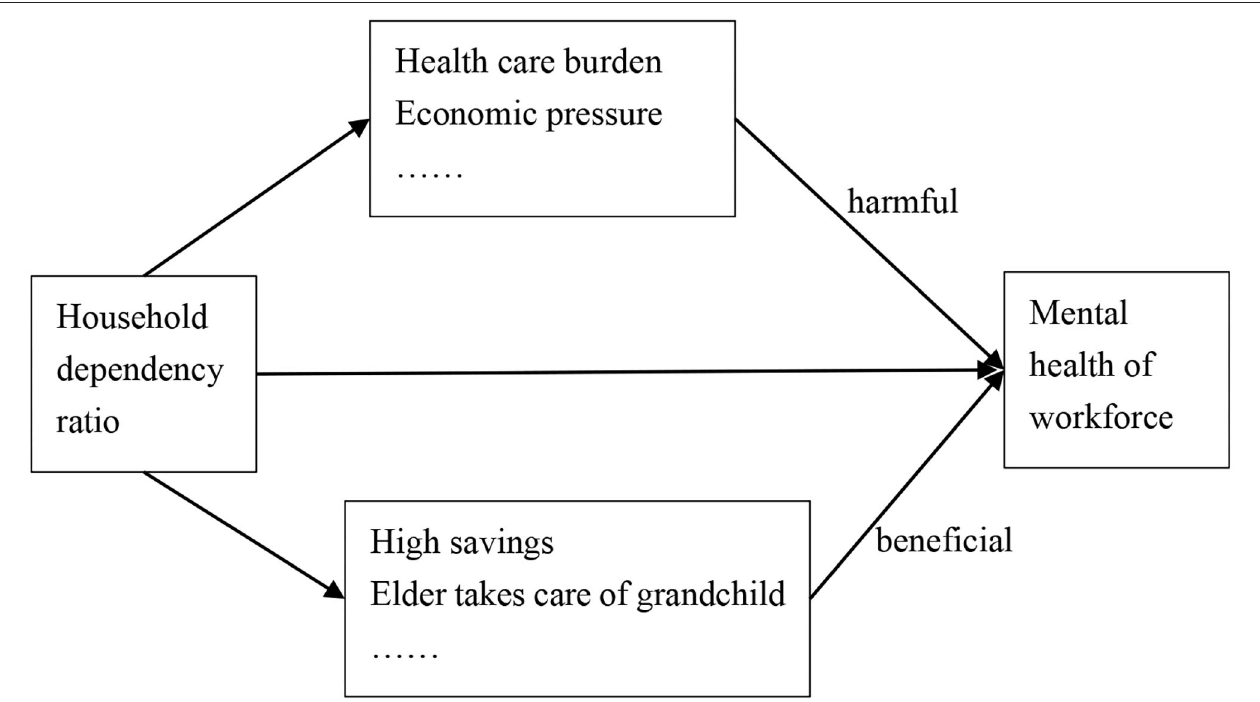
FIGURE 2 | Conceptual framework of the